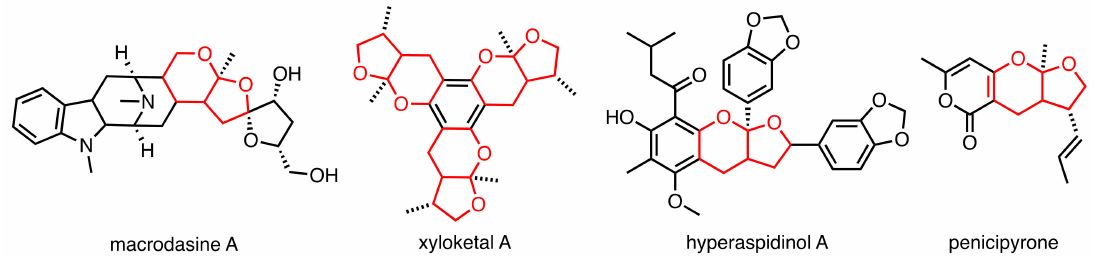
Figure 1. Representative natural products with 4 H -furo[2,3- b ]pyran sca ff